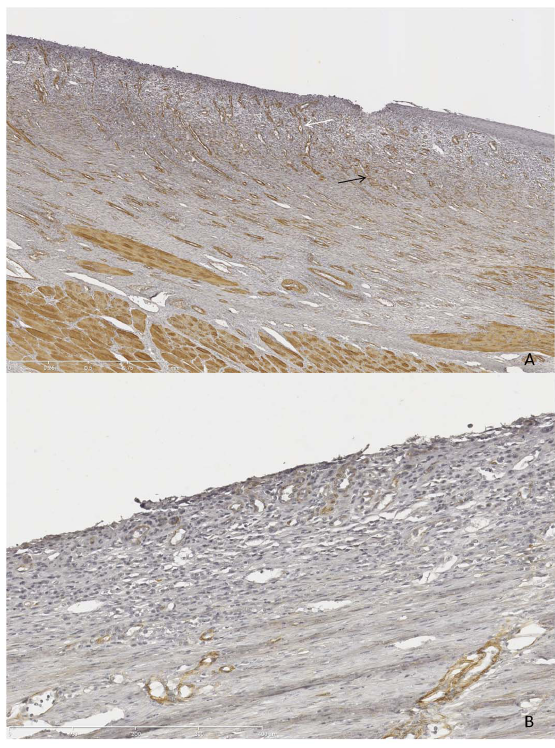
Figure 4. Immunohistochemistry staining with anti- a SMA antibody, original magnification 6 200. Strong signal (brown spots) attesting high myofibroblastic activity (panel A, black arrow) and high vascular density (panel A, white arrow) in control (A); nearly absent signal in MA-treated swine (B).